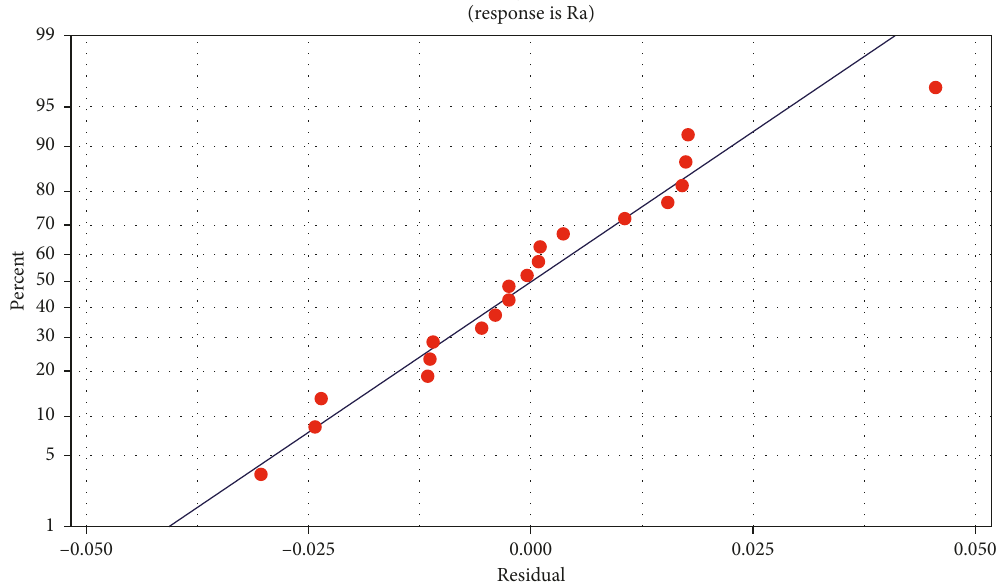
Figure 5: Normal probability plot of the residuals of surface roughness. The wire EDM process completed the given input process parameter. Shapes of component profile are shown in Figure